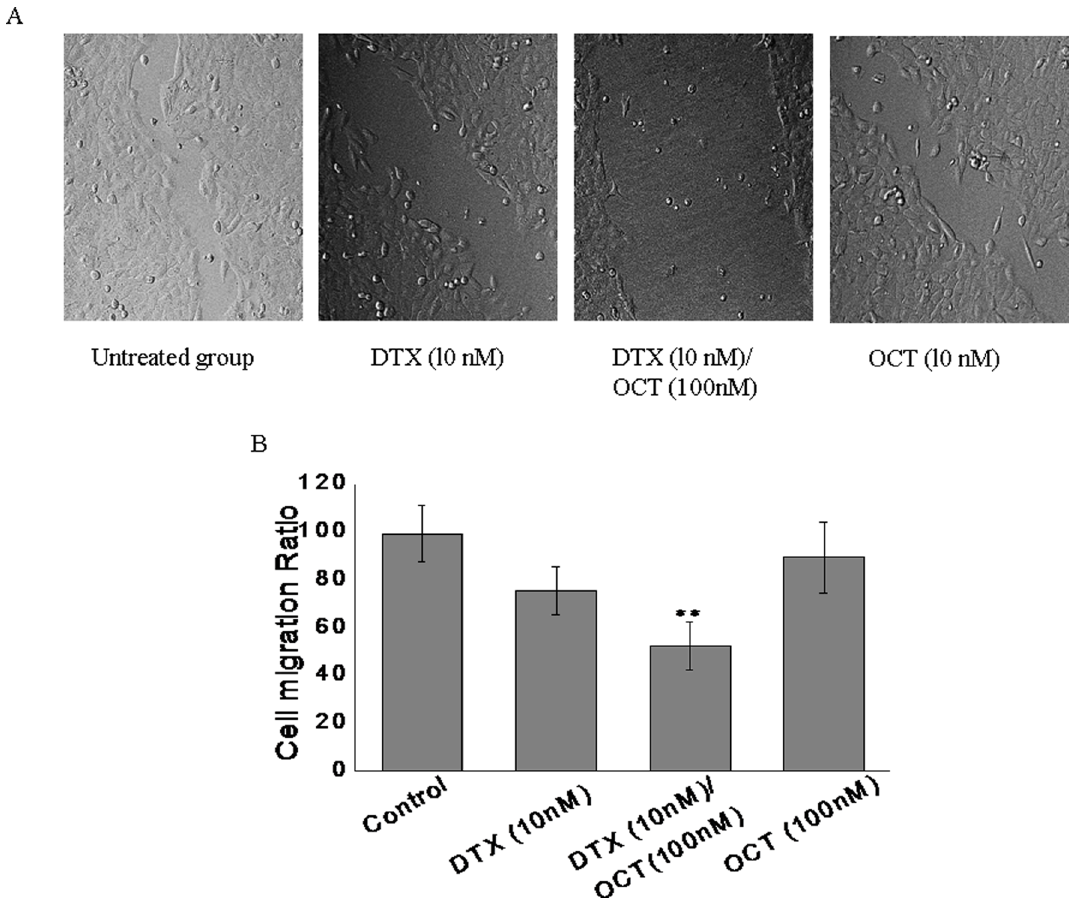
Figure 6. Effects of DTX, OCT alone and two-drug combination on DU145 cells migration. (A) Wound healing assay to determine the effect of indicated drugs on DU145 cells migration. (B) The summarized migration ratio (%) following 72 h treatment measured by wound healing assay. Each column represents the mean 6 SEM. ** p , 0.01, vs. control.